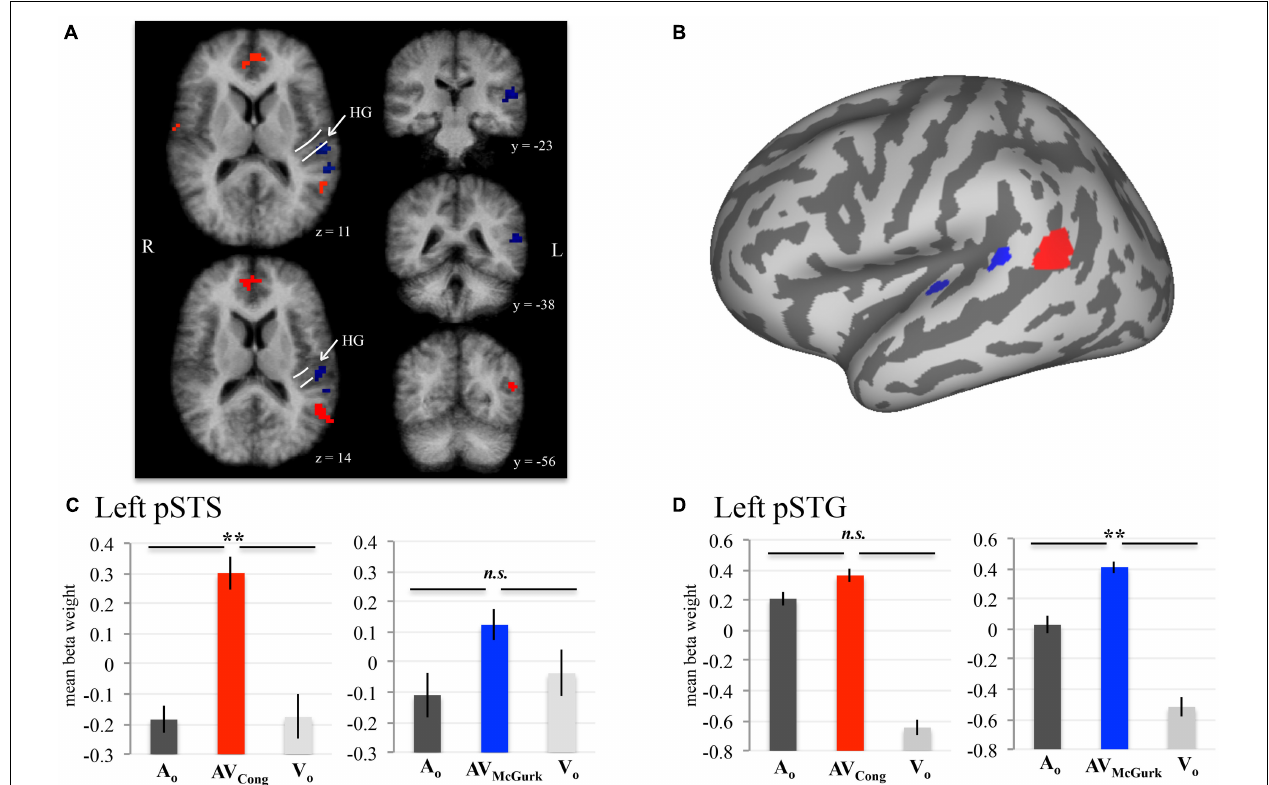
FIGURE 1 |AV speech areas in the left posterior superior temporal cortex for congruent and McGurk speech. Group results ( N = 10; p corr < 0.001) showing voxels with significantly higher fMRI signal for AV speech than both types of unimodal speech (acoustic-only, A O and visual-only, V O ) are displayed on axial ( z = 11, 14) and coronal ( y = –23, –38, –56) 3D volume slices of the averaged brain created from the current sample (A) . The anatomic designations were determined in 3D volume space relative to the anatomy on the current sample’s averaged brain. The white lines displayed on the axial volume slices approximate the location of HG. Results presented in 3D volume are not interpolated and are presented in radiological convention. The inflated cortical surface template shown in (B) , used for display purposes, was not created from the current sample. A